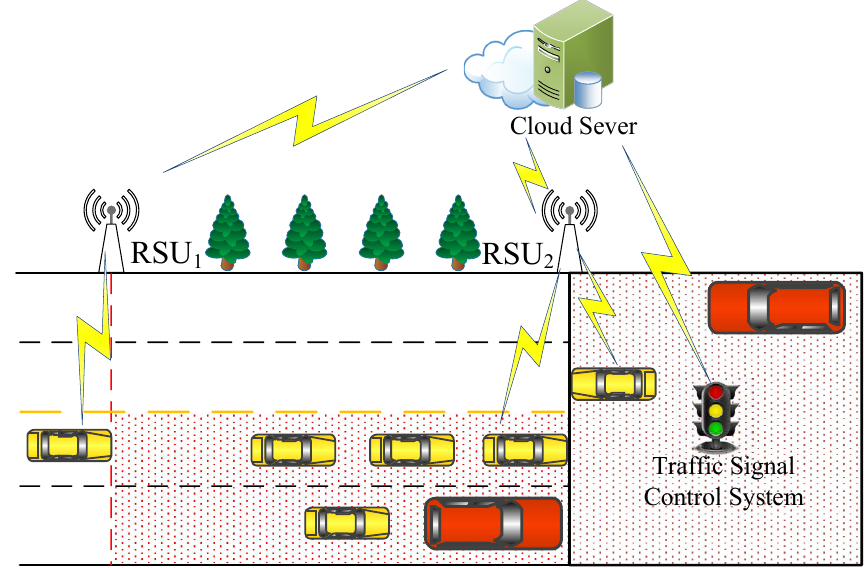
Figure 1. System